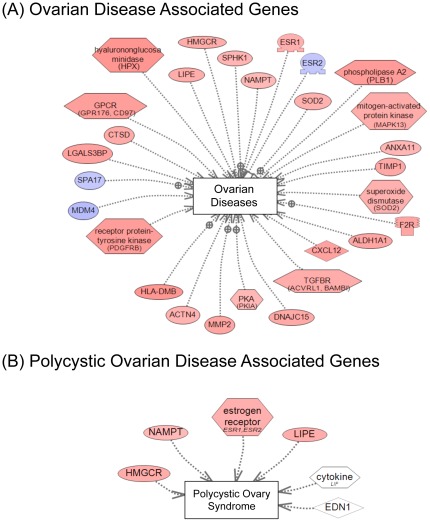
Ovarian diseases associated differentially expressed genes between F3 generation vinclozolin and control lineage granulosa cell.Sub-networks were identified using global literature analysis with Pathway Studio™. Node and arrow code is the same as for Figure 6. A: General ovarian diseases associated genes. B: Polycystic ovarian disease associated genes. White color nodes indicate differential methylated regions identified in this study.